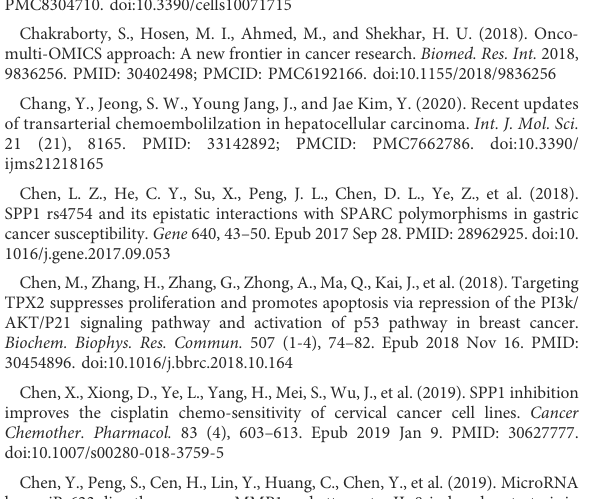
SUPPLEMENTARY TABLE S1 Treatment details for HCC patients in